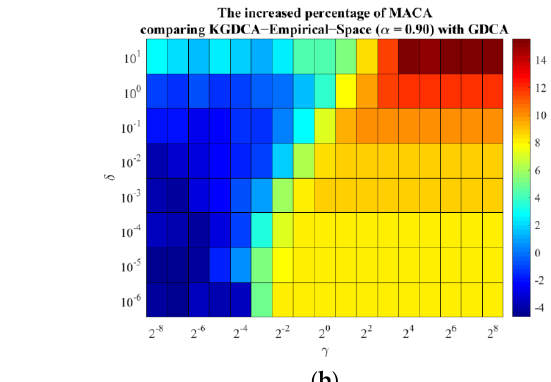
SVM when α = 0.9. ( a ) KGDCA − Intrinsic − Space driven SVM; ( b ) KGDCA − Empirical − Space driven SVM.